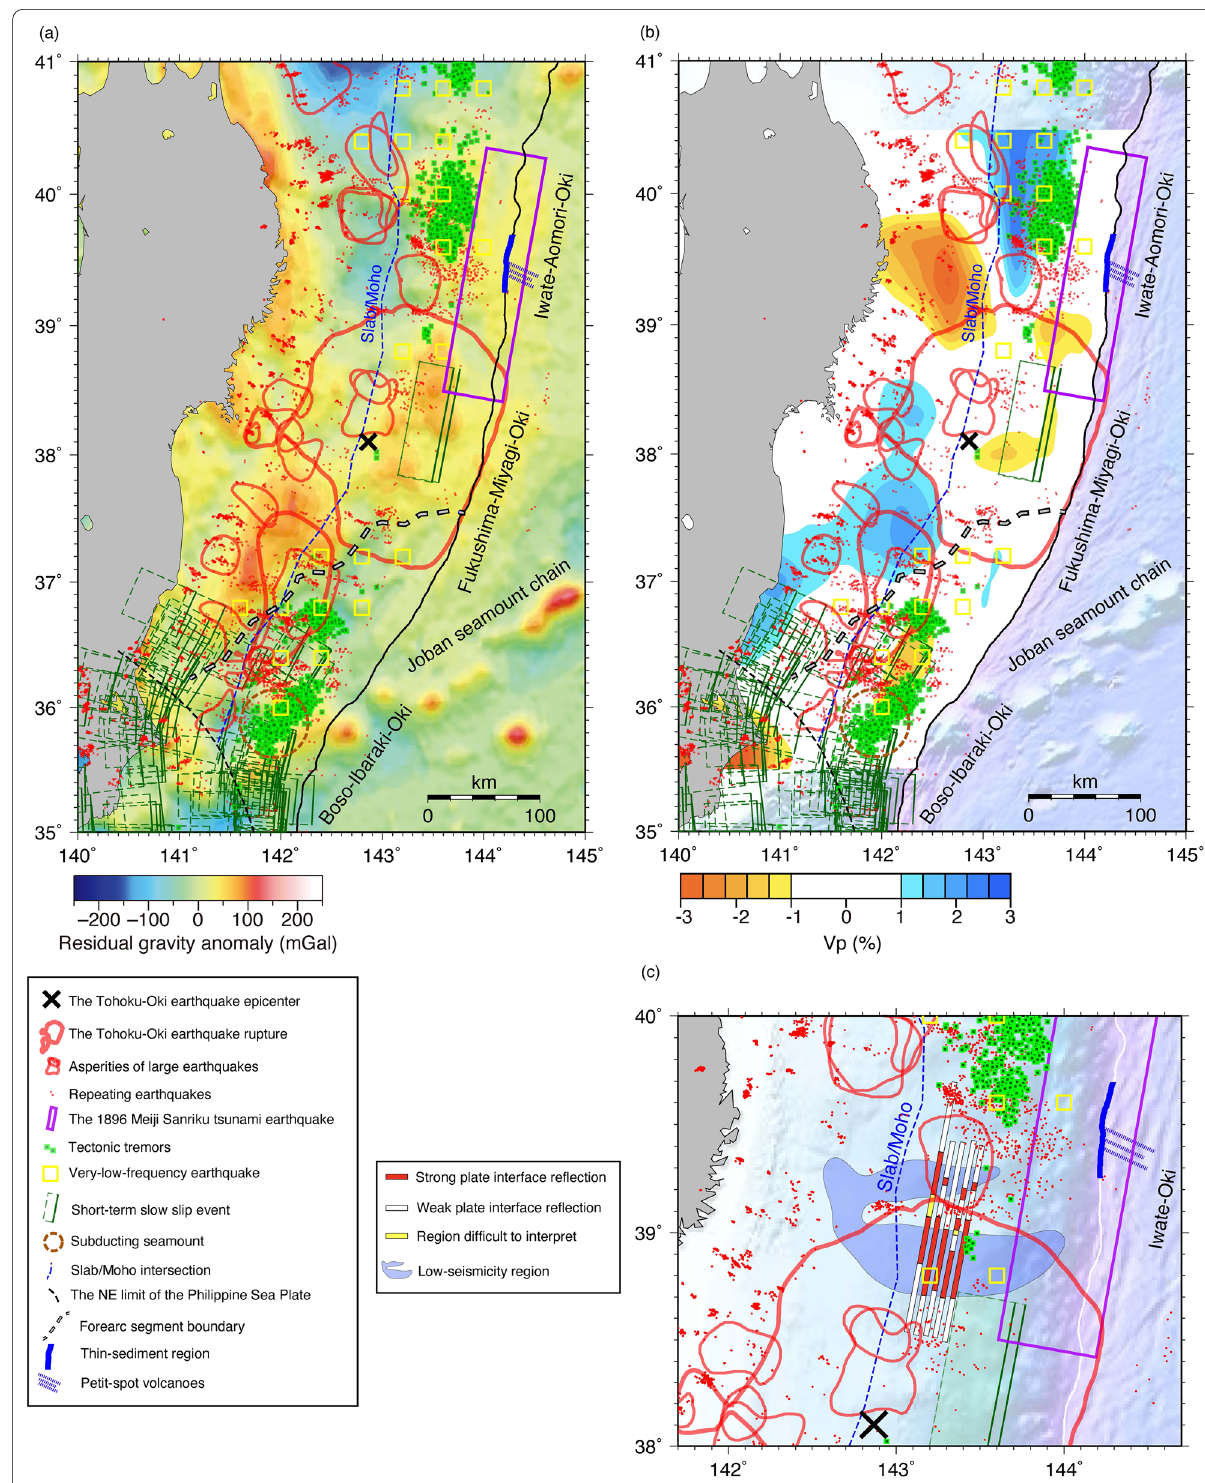
Fig. 12 (See legend on previous